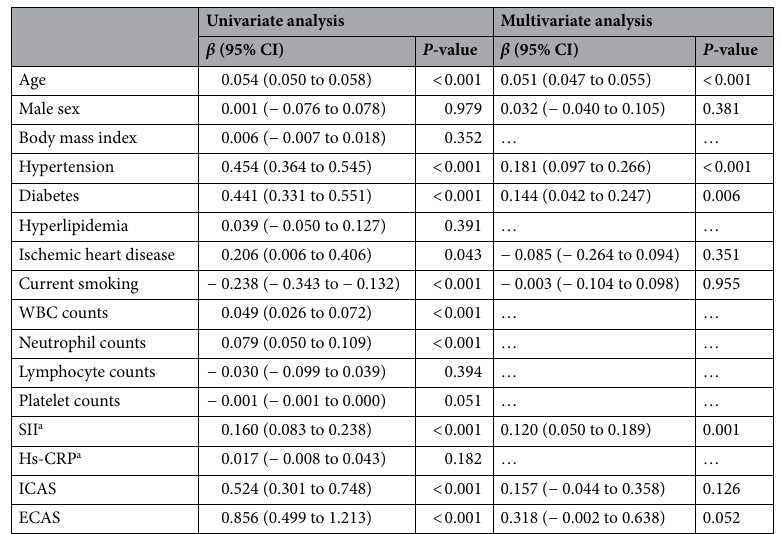
Table 1. Simple and multiple linear regression analyses between possible predictors and the square root of white matter hyperintensity volume (these variables were transformed into square root scales). WBC white blood cell, SII systemic immune-inflammation index, hs-CRP high-sensitivity C-reactive protein, ICAS intracranial atherosclerosis, ECAS extracranial atherosclerosis. a These variables were transformed into log scales.